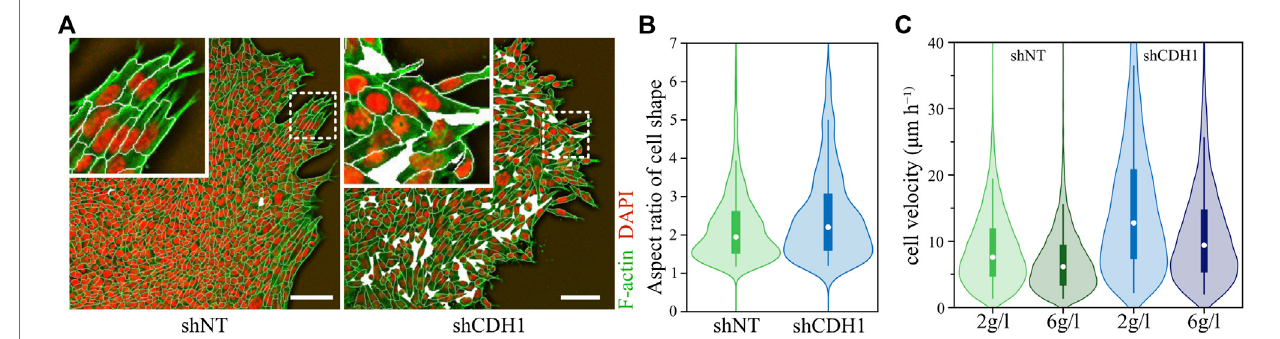
FIGURE4| DownregulationofE-cadherinpromotesunjamminginmigratingcelllayer. (A) Morphologyofwild-type(shNT)andE-cadherindownregulated(shCDH1)cell layersmigratingatacollageninterface.Thewild-typecellaggregateisalmostarea- fi llingandexhibitshighspatialcorrelationsforthelongaxes — theorientation — ofthecells. E-Cadherinknockoutcellaggregatedisplaysdensity fl uctuations,andcellsarerandomlyaligned.Actinisstainedingreen(AlexaFluor568-conjugatedphalloidin),whilenuclei arestainedinred(DAPI).Thewhitelinesvisualizeacellsegmentationwithholesinthetissuerepresentedbywhiteareas.Thescalebarrepresents100 μ m. (B) Change ofaspect ratio due to lossofE-cadherin. An increaseinaspect ratio corresponds tohighershape indices, thus promoting unjamming oftissue. (C) Changeincellmigration velocity due to downregulated E-cadherin and promoted unjamming. Graphics and data were adopted from Ilina et al. [5].